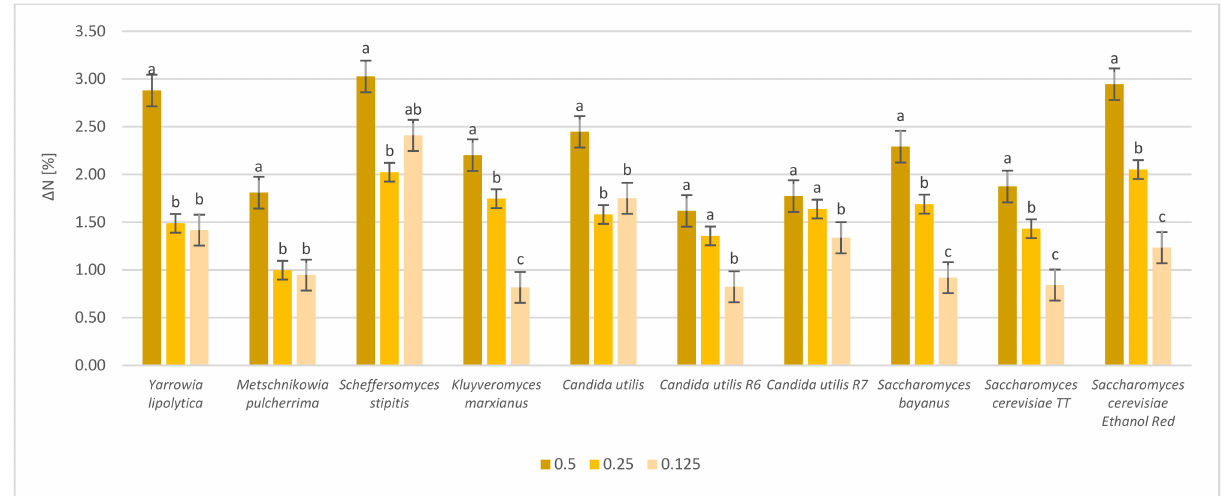
Figure 3. Protein content increase expressed as ∆ N [%], after cultivation of dried sugar beet pulp with selected yeast strains. The dried biomass was hydrolyzed with various enzyme doses (0.5 mL/g DM; 0.25 mL/10 g DM; 0.125 mL/10 g DM). The results were adjusted to exclude influence of enzyme preparations. a, b, c—indicators of statistically significant difference, mean values for strain with different letters are significantly different ( p < 0.05).